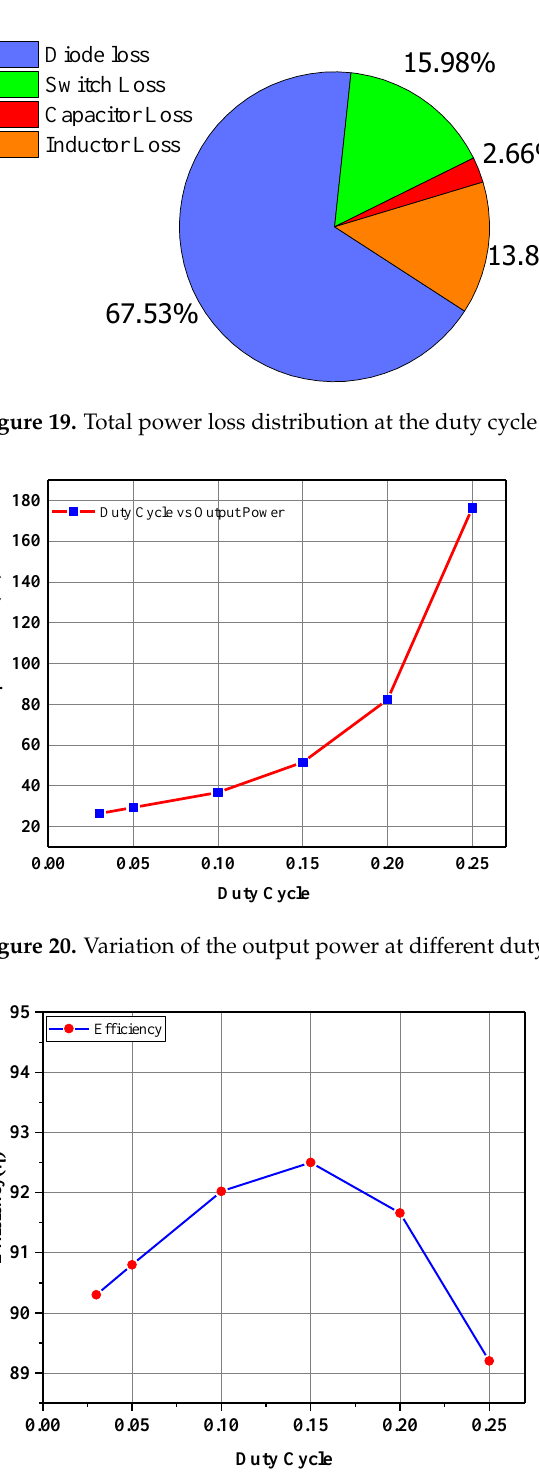
Figure 22. Ideal output voltage against the simulated output voltage with parasitic parameters and the experimental output voltage at different duty cycles. 10. Conclusions and Future Research An advanced and efficient model of the switched Z-source DC-DC converter (HS- SZC) is presented in this study. The model is proposed using one inductor and switch at the backend of the conventional model of Z-source DC-DC converter and the derived voltage gain, i.e., ( 3 − 4D ) / ( 1 − 3D ) clearly specifies the significant improvement in the boost ability of the newly designed Z-source DC-DC converter. The theoretical voltage gain of 4.36 at D = 0.15 is achieved, while the simulation and experimental gains are rec- orded as 4.28 and 4.21, respectively. The proposed design obtains a higher gain at a very small duty cycle, i.e., D ≤ 0.33; thus, it eliminates the problems of the circuit complexity and larger duty cycle. Moreover, compared to the conventional Z-network converters, it utilizes a lower part count, which simultaneously reduces the cost and enhances the con- version efficiency. The proposed switched converter has a wide range of load capacity and voltage gains, which makes it suitable for applications with RESs. Finally, simulation and experimental results clearly justify the theoretical findings associated with the pro- posed converter. Future research will deal with the employment of the proposed topology with real applications, i.e., inverter, PV panel, etc. Author Contributions: Conceptualization, R.K. (Rahul Kumar) and R.K. (Ramani Kannan); meth- odology, R.K. (Rahul Kumar) and A.M.; formal analysis, N.B.M.N. and A.M.; investigation, N.B.M.N. and R.K. (Rahul Kumar); writing—original draft preparation, R.K. (Rahul Kumar) and